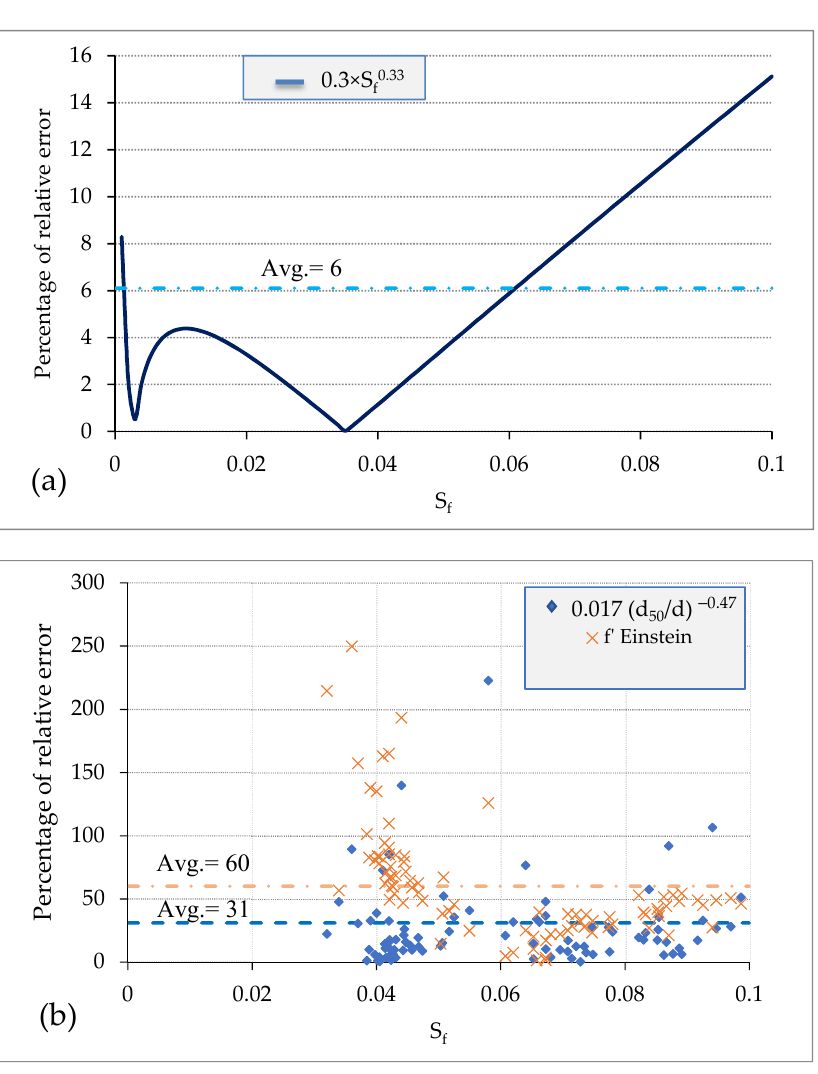
Figure 10. The relative errors of Equation (21) ( a ) and Einstein Equation ( b ) in comparison with BLCM for determining the skin friction factor. The horizontal axis represents the total energy slope.